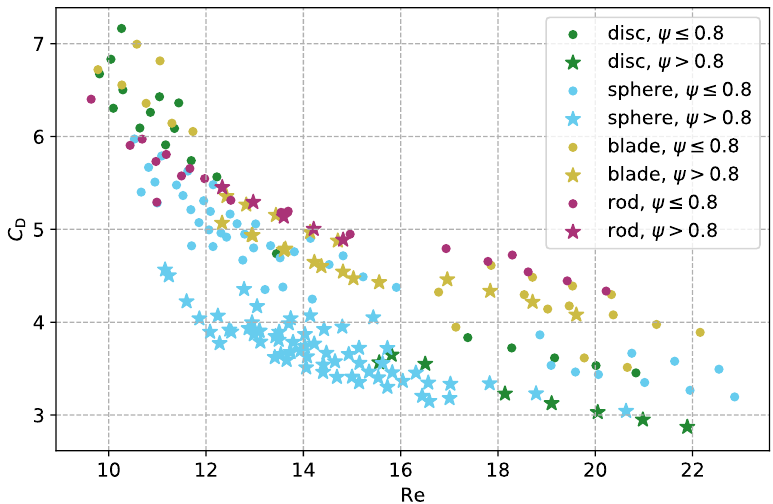
Figure 11. The drag coefficient plotted against the Reynolds number, color with shape classification according to Zingg [5]. A spread is revealed, describable via the sphericity (marker